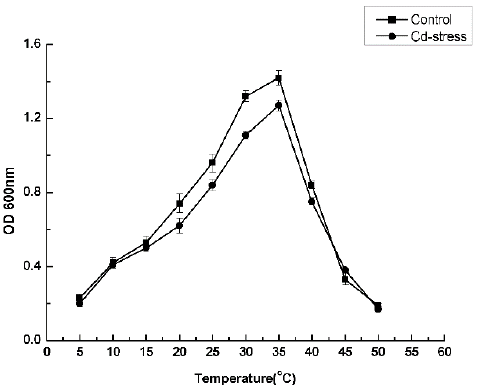
Figure 3. The optimum temperature of P. shigelloides H5 with and without Cd 2+ stress. ( p = 0.016).